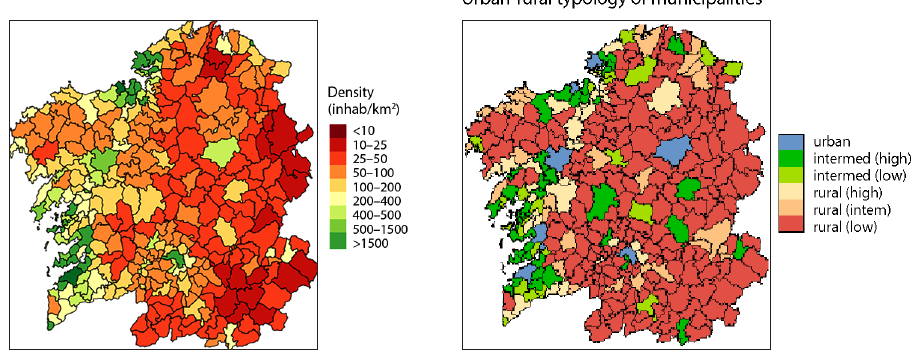
Figure 1. Distribution of Galician population. Density by municipalities 2011 and urban-rural